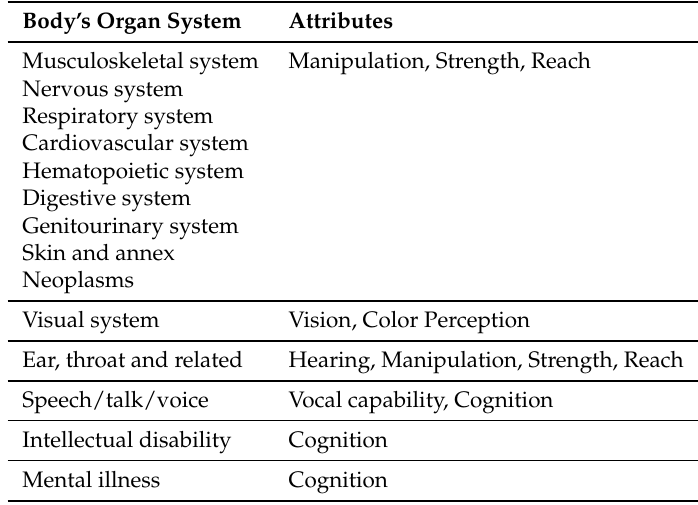
Table 4. Parallelism between attributes and body’s organ